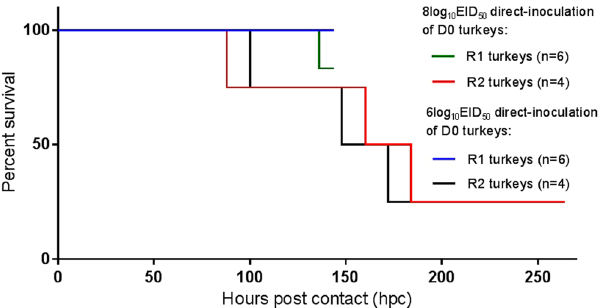
Figure 3. Kaplan-Meier survival plots of contact-infected R1 and R2 turkeys. Hours post contact denotes the time (hours) after introduction of the contact turkey groups into the two pens, i.e. at 4 and 7 dpi for the R1 and R2 contacts respectively (Fig. 1). The R1 turkeys were housed between 1–7 dpi, i.e. for a total of 144 hrs (6 days) maximum, with one death occurring in the 8log 10 EID 50 pen at 136 hpc (5.67 dpc). The R2 turkeys were introduced at 96 hpc (4 dpi) and housed to the end of the study at 15 dpi, i.e. for 264 hrs maximum. However, R2 turkey deaths occurred between 100–172 hpc (mean death time (MDT): 140 hrs (5.83 days)) and 88–184 hpc (MDT: 144 hrs (6.0 days)) in the 6log 10 EID 50 and 8log 10 EID 50 pens respectively. No deaths occurred in any of the D0 turkeys directly-infected with either dose during their 4-day housing, i.e. prior to their removal at 4 dpi (not